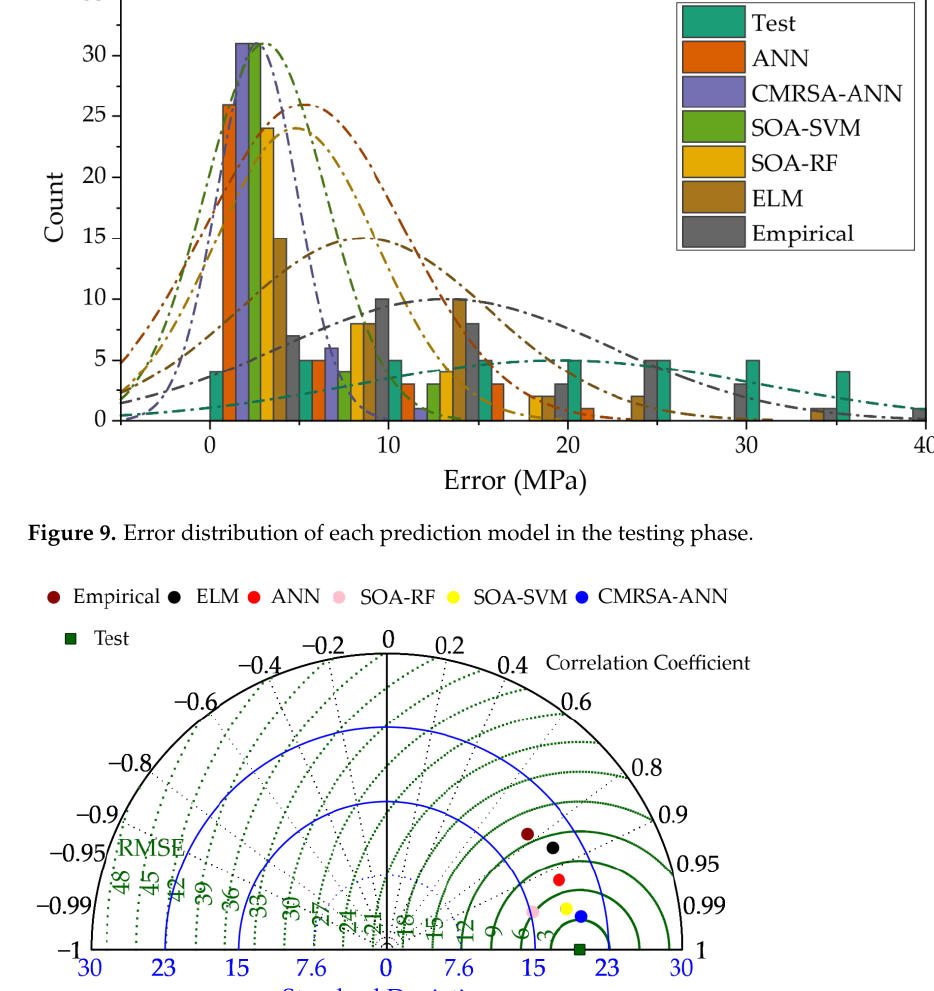
Figure 9. Error distribution of each prediction model in the testing phase.